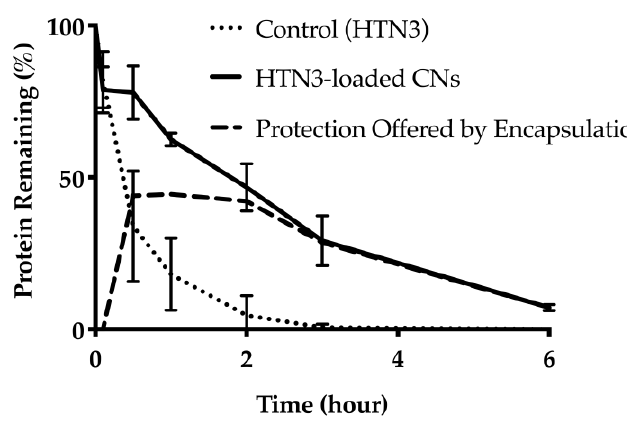
8 of 15 Figure 4. ( a ) Release of HTN3 from CNs at different pH values. The highest extent of release and most rapid release was observed at pH 3, and there was minimal release at pH 6.8. On average, at pH 3, the CNs were able to release 84% ± 7% of the encapsulated protein, 58% ± 9% at pH 4, 36% ± 3% at pH 5, and 2% ± 2% at pH 6.8. ( b ) pH cycling release results show that the CNs can adapt to environmental pH changes and can release protein selectively at pH 4 over 3 pH cycles. 3.1.5. HTN3 Degradation Study in WSS To assess the protection offered through encapsulation against enzymatic degrada-